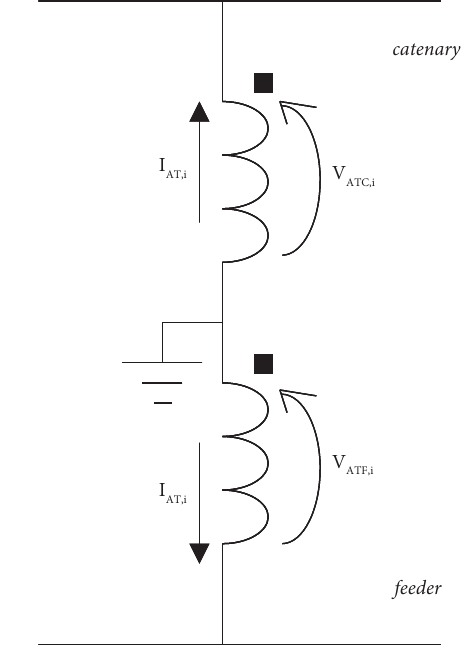
Figure 4: Sketch to illustrate the variables and their signs in